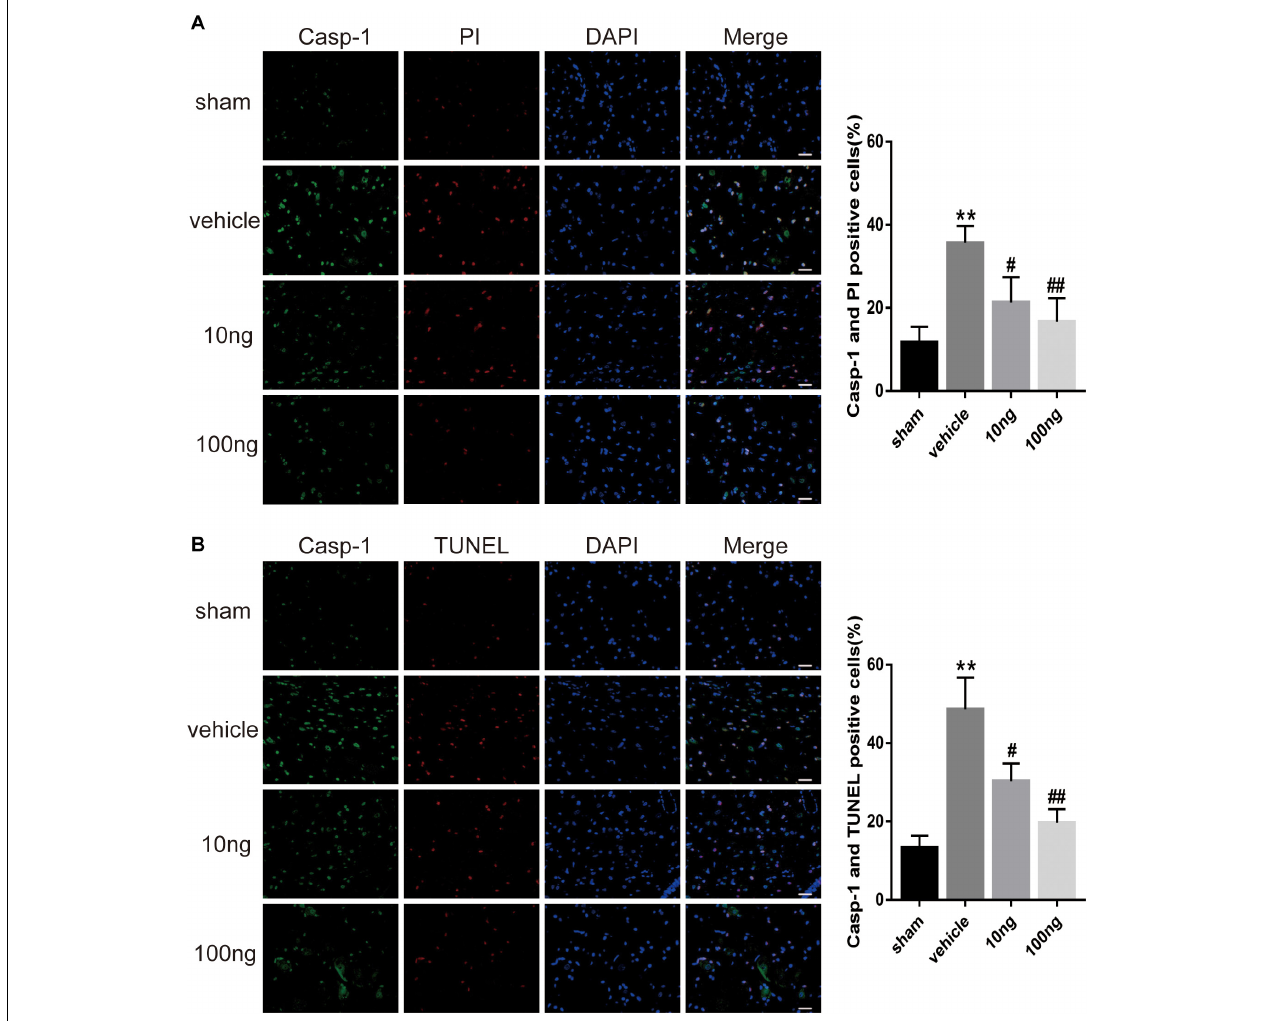
FIGURE 5 | MaR1 attenuated pyroptosis in spinal dorsal horns ( n = 5/group). Double immunofluorescence staining was employed to examine the pyroptosis in spinal dorsal horns. It was determined as pyroptosis if double positive of cleaved Caspase-1 and TUNEL (or PI) occurred. (A,B) The frequency of pyroptotic in spinal cord was attenuated after the application of MaR1 dose-dependently. Data are given as the mean ± SD (** P < 0.01 versus the sham group; ## P < 0.01 versus the vehicle group; # P < 0.05 versus the vehicle group); scale bars = 25 µ